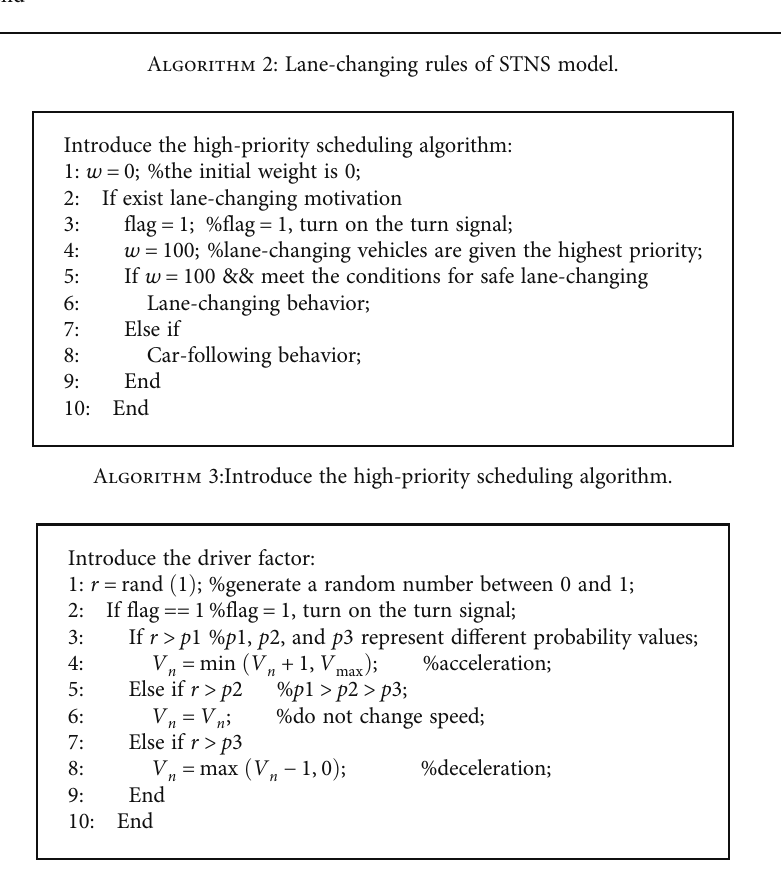
Algorithm 4: Introduce the driver factor.